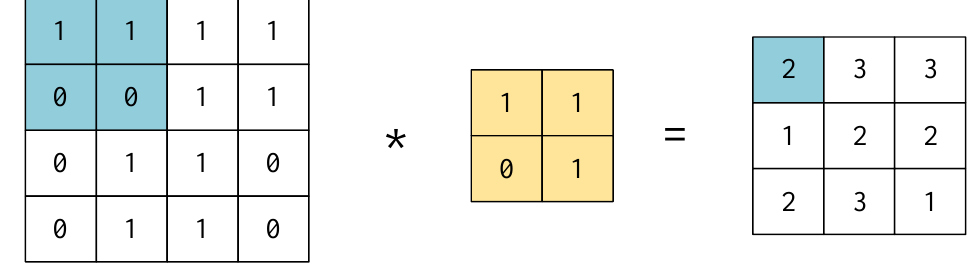
Figure 2. The process of the convolution operation.